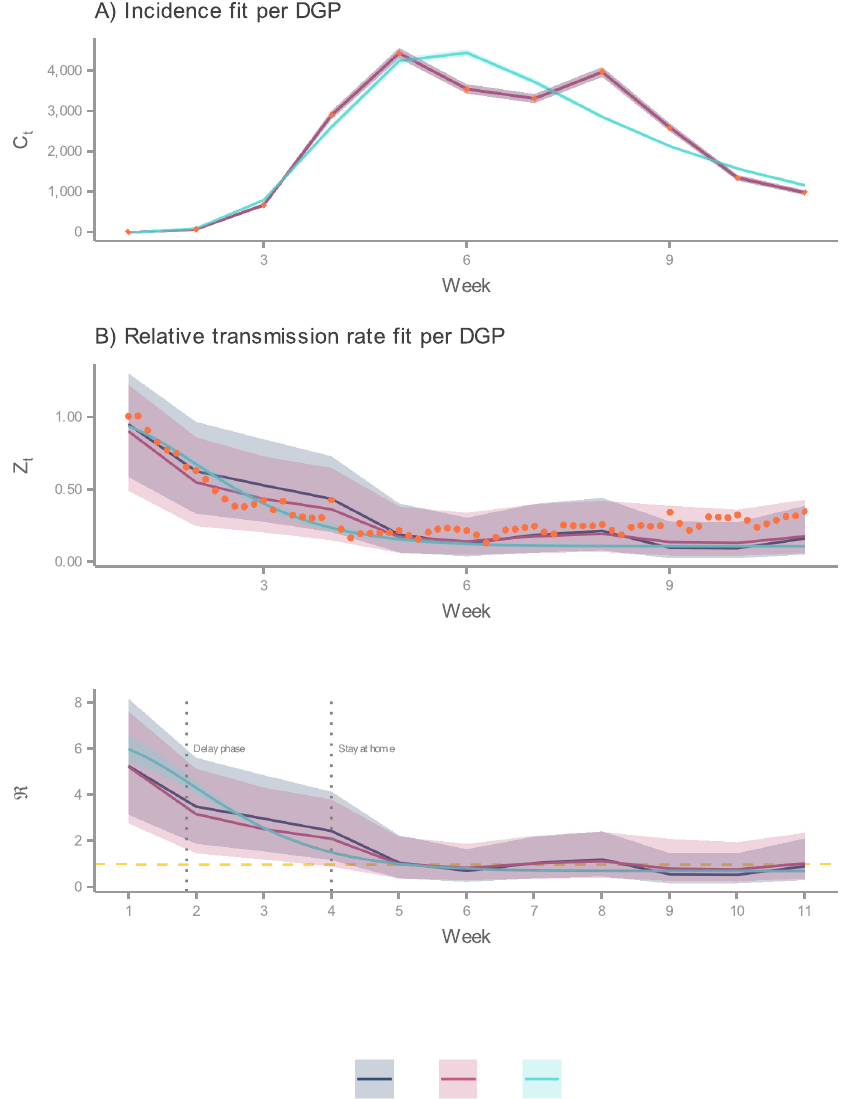
Fig 7. Comparison of predicted latent states. In this plot, predicted values stem either from the filtering distribution (DGP1 and DGP2) or the posterior predictive distribution (DGP3). Here, DGP3’s process model corresponds to the structure that describes the transmission rate in terms of a 4th-order information delay. Further, solid lines indicates the median, and the ribbons represent the 95% CI. (A) Comparison between predicted incidences by DGP (solid lines and ribbons) and weekly detected COVID-19 cases (rhombi) in Ireland during the first wave. (B) Comparison between predicted relative transmission rates by DGP (solid lines and ribbons) and Apple’s driving mobility indexes (points) in Ireland during the first wave. (C) Predicted effective reproductive numbers by DGP (solid lines and ribbons) during Ireland’s first COVID-19 wave. The dashed horizontal line denotes the epidemics